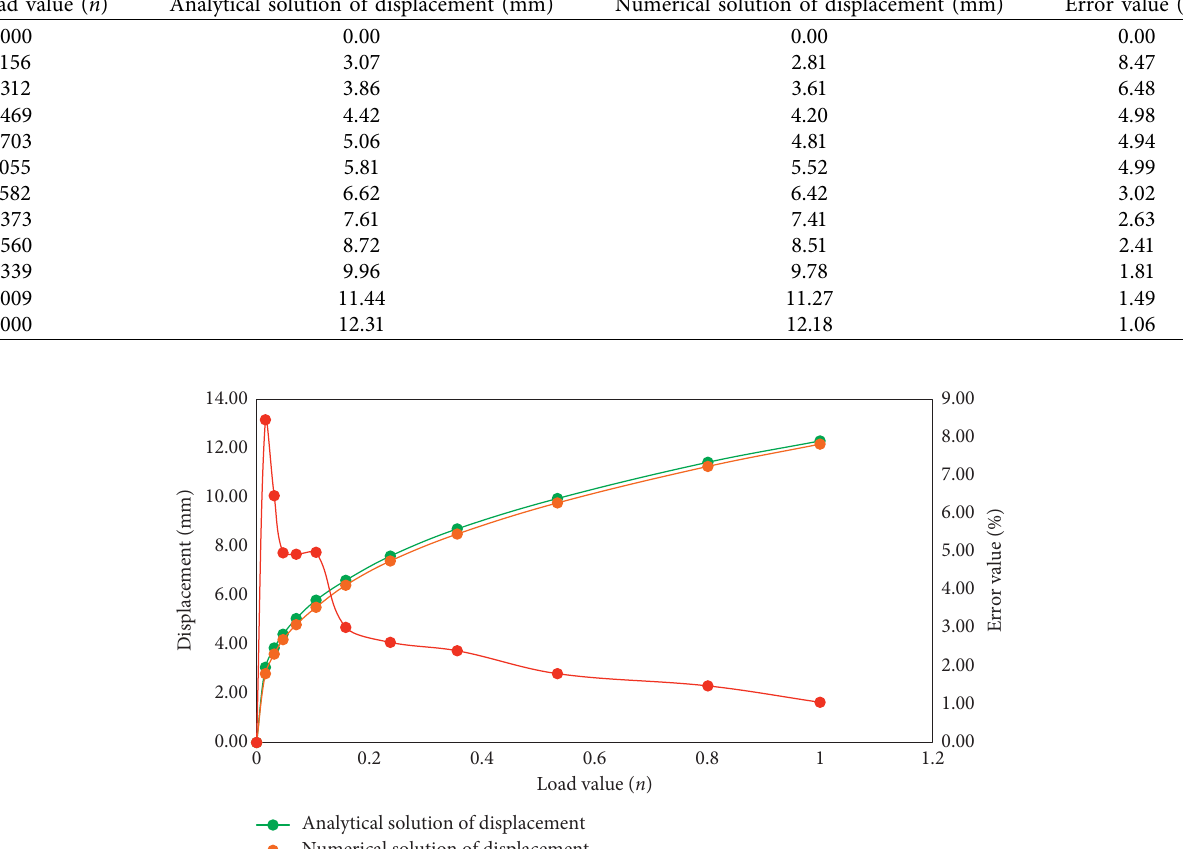
Table 4: Comparison between numerical solution and analytical solution of single string beam element of badminton racket. Load value ( n )